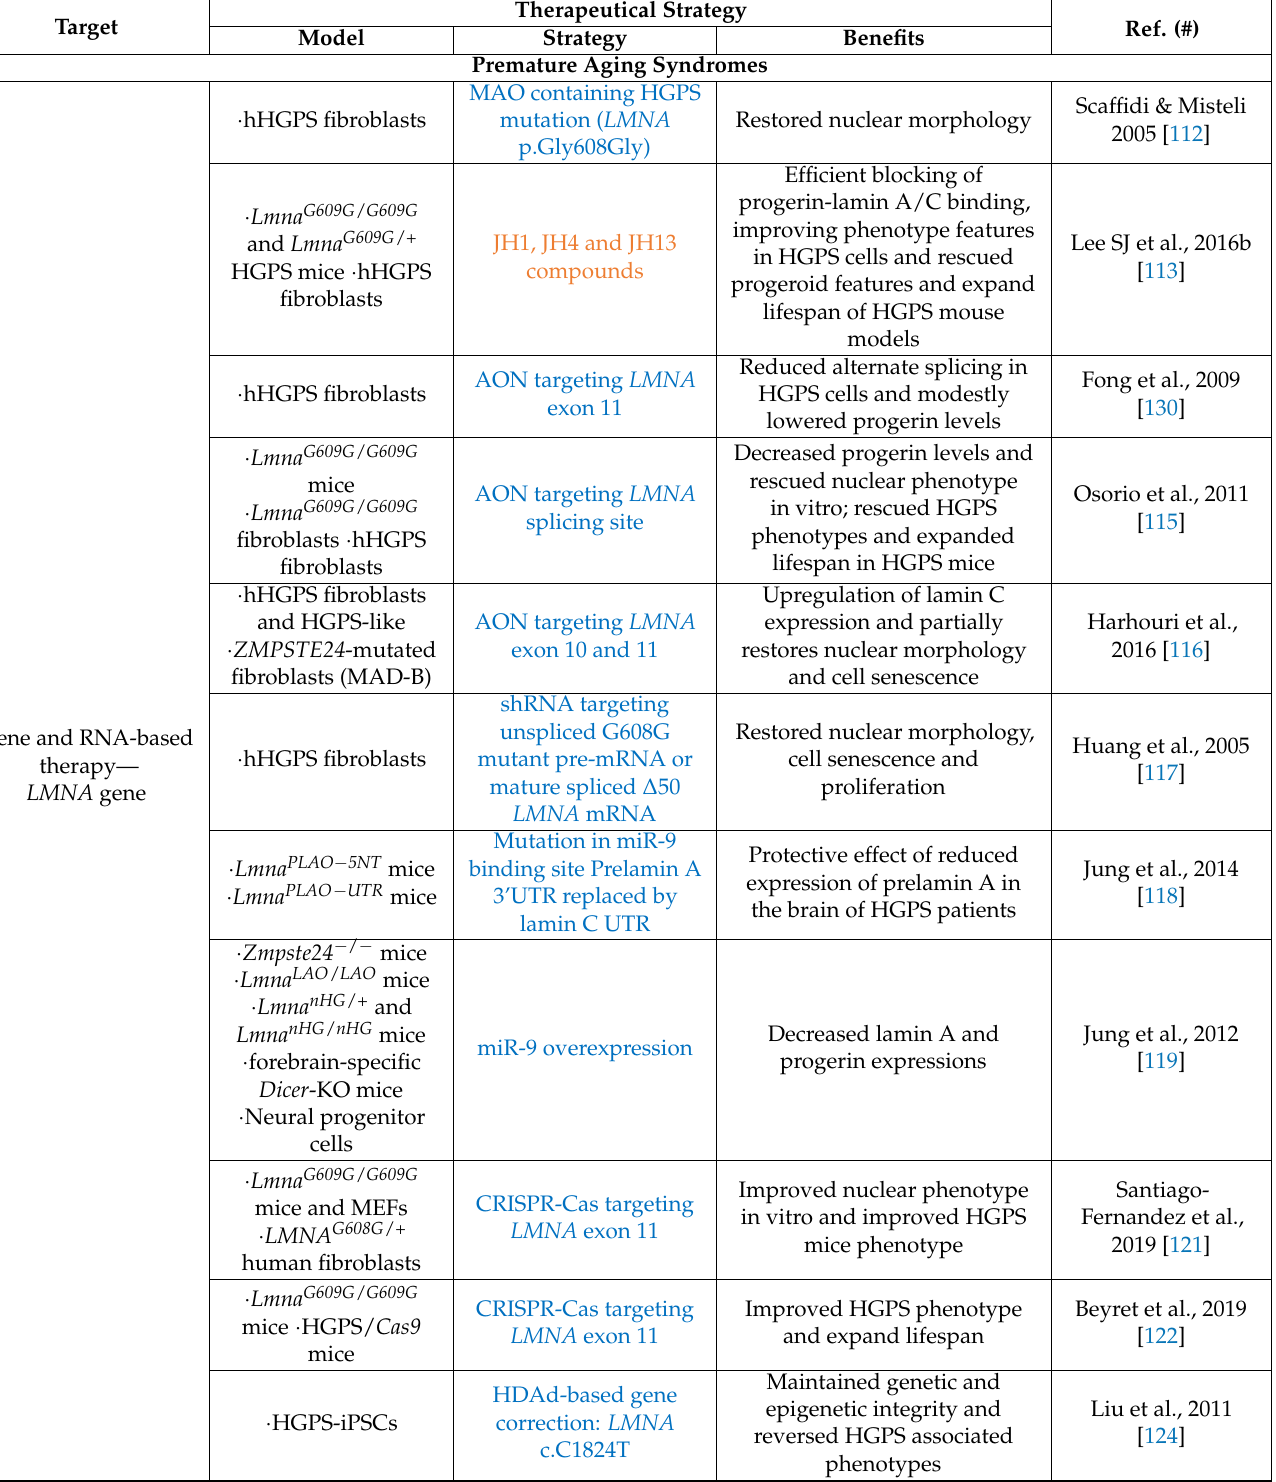
Table 2. Literature review of preclinical therapeutic strategies in premature aging syndromes and